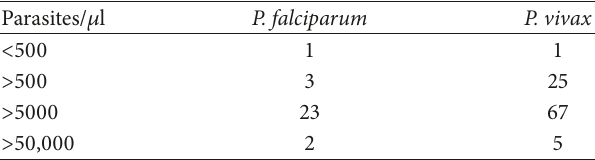
Table 1: Parasite load/ 𝜇 l as estimated by microscopy. Parasites/ 𝜇